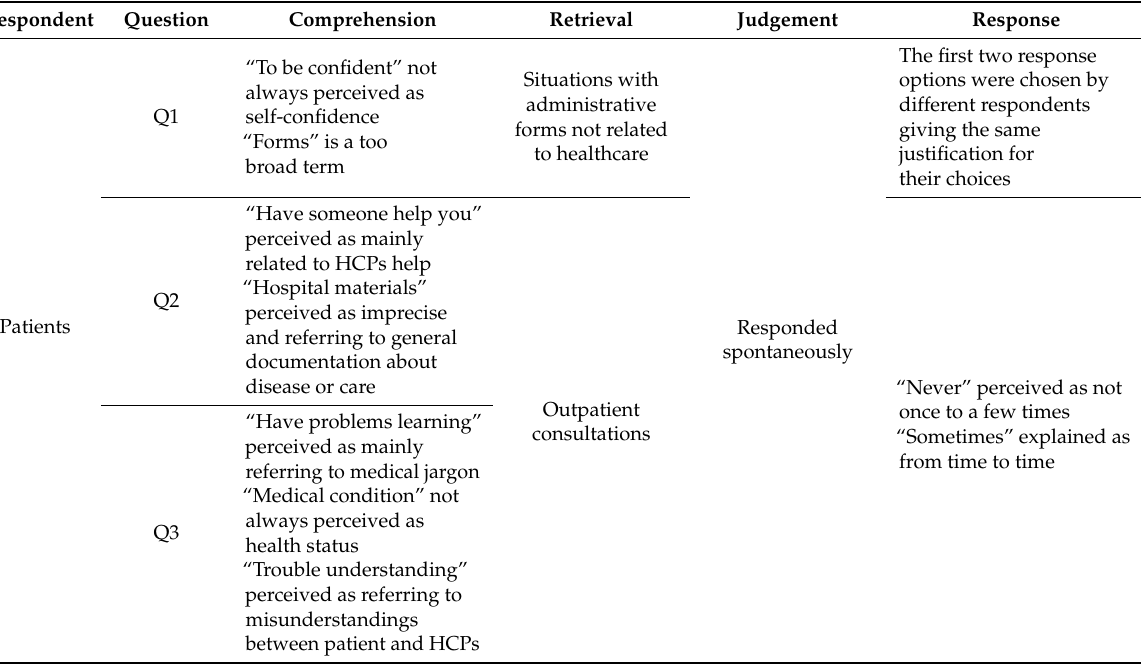
Table 5. Key findings from cognitive interviews following the Tourangeau survey response model.